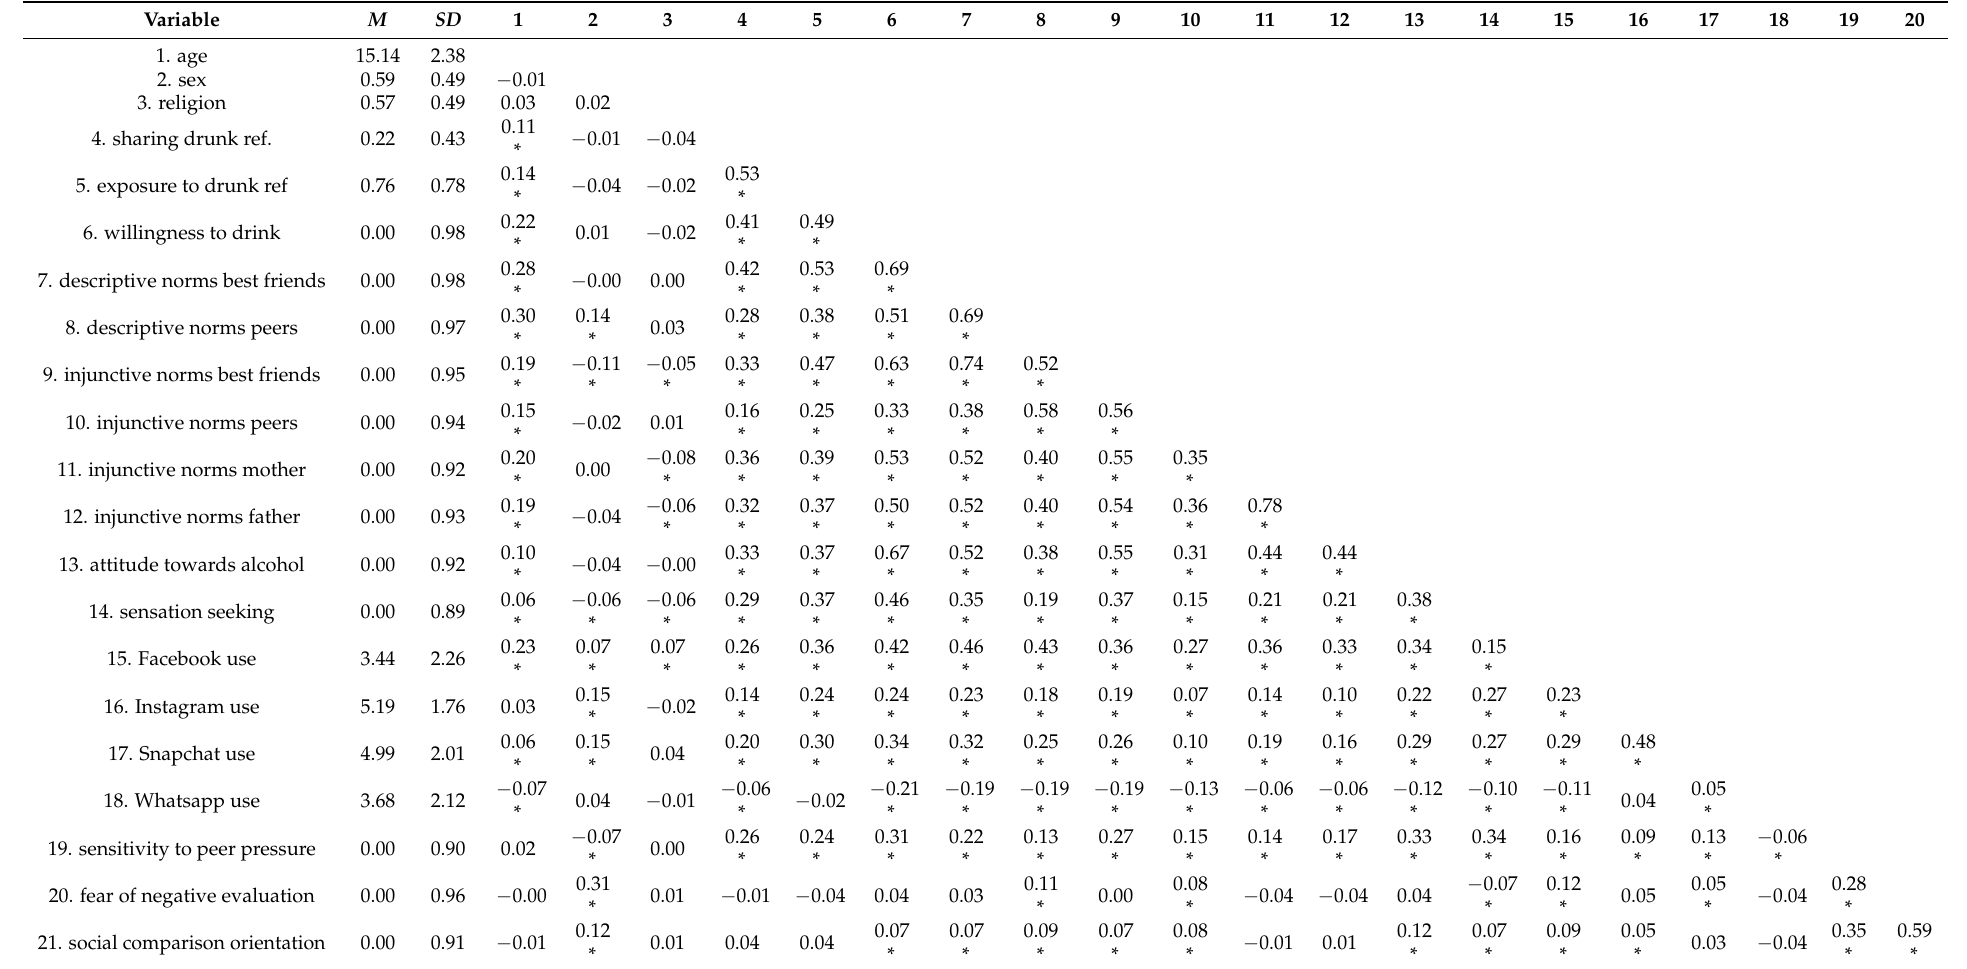
Table 2. Means, standard deviations, and